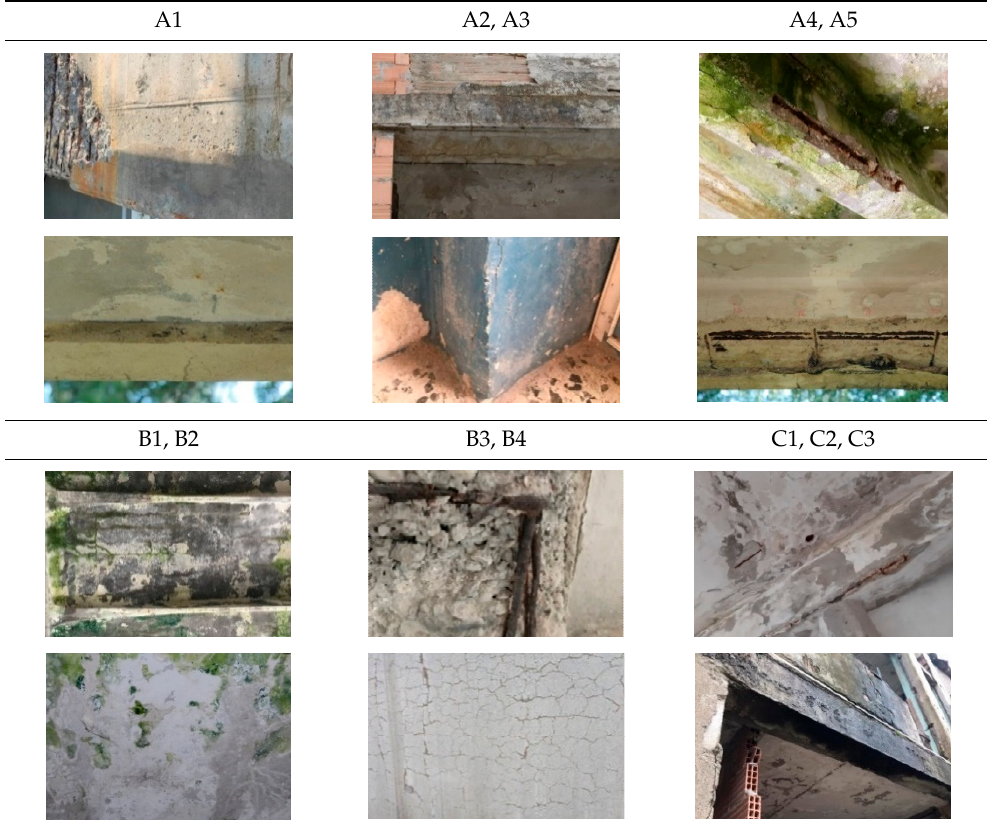
Table 2. Abacus of the possible visible deterioration conditions.